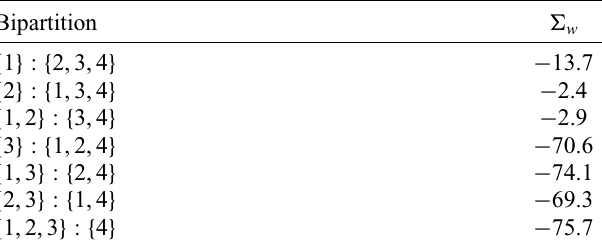
TABLE I. Significance of detected entanglement for all biparti- tions using the estimate of Eqs. (7)–(8). The highest significance is obtained for partitions separating modes 3 and